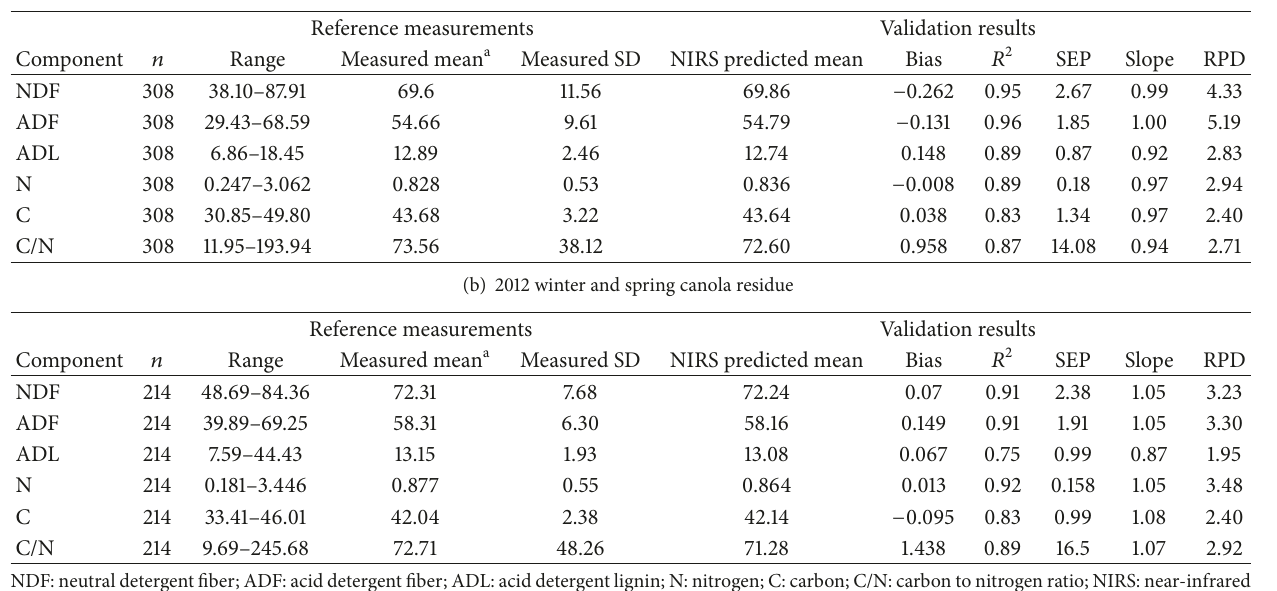
Table 2: Reference measurements and validation results for the prediction of 2011 and 2012 winter and spring canola residue NDF, ADF, ADL, N, C, and C/N using